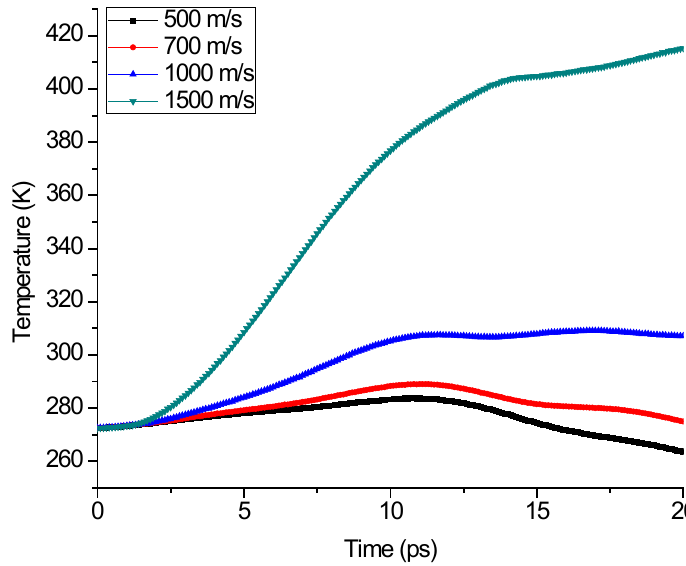
Figure 13. The temperature evolution at the periphery of the Cu/Cu interfacial region at different impacting velocity of 500 m/s, 700 m/s, 1000 m/s, and 1600 m/s of single particle impact.